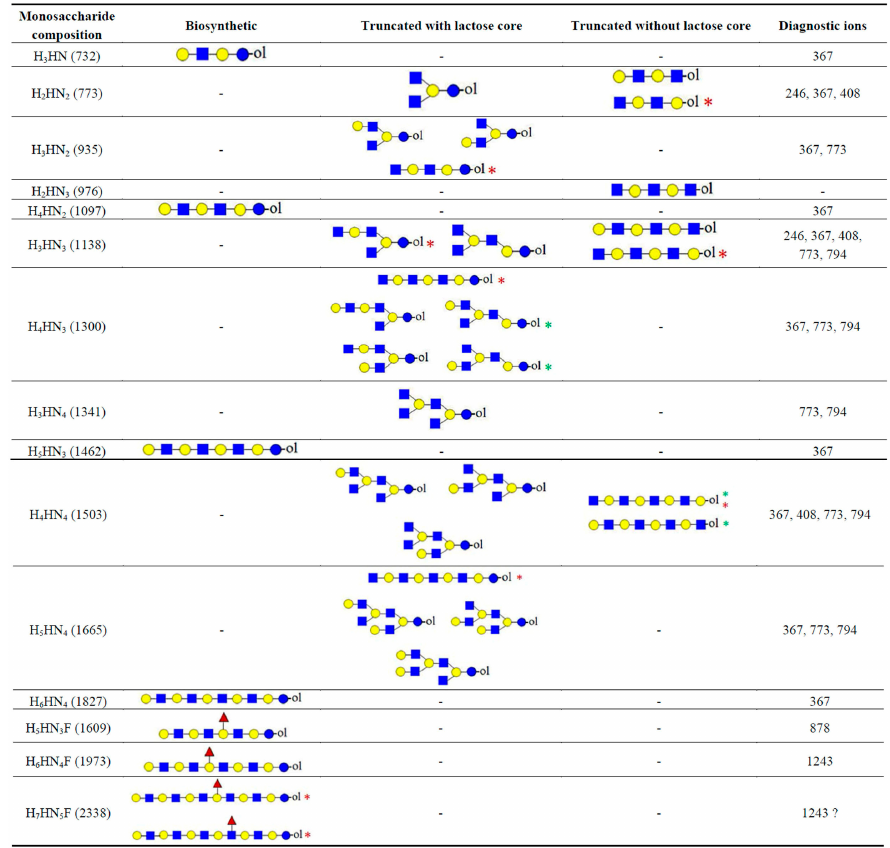
Table 2. Confirmed and proposed oligosaccharide alditol structures along with respective diagnostic ions. Additional branched isomers are possible, due to galactose 1–3 and 1–4 linkages, and most of them are further fucosylated in vivo with fucose 1–2, 1–3 or 1–4. denotes N -acetylglucosamine, galactose, glucose and fucose. * structures that could be neither confirmed nor excluded. * present in very small amounts. Reproduced from [49]. Copyright MDPI, 2014.